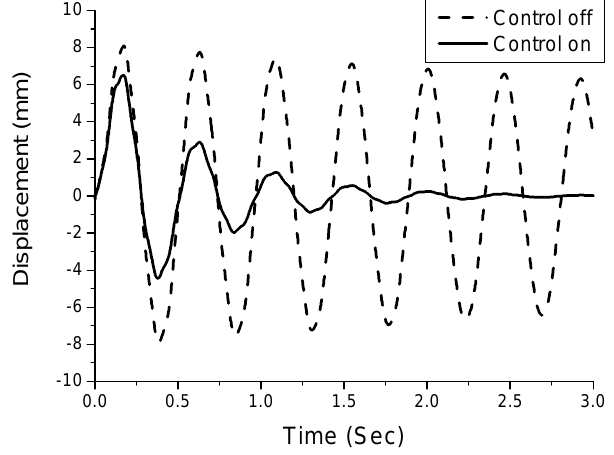
Fig. 6. Displacement response to impulse